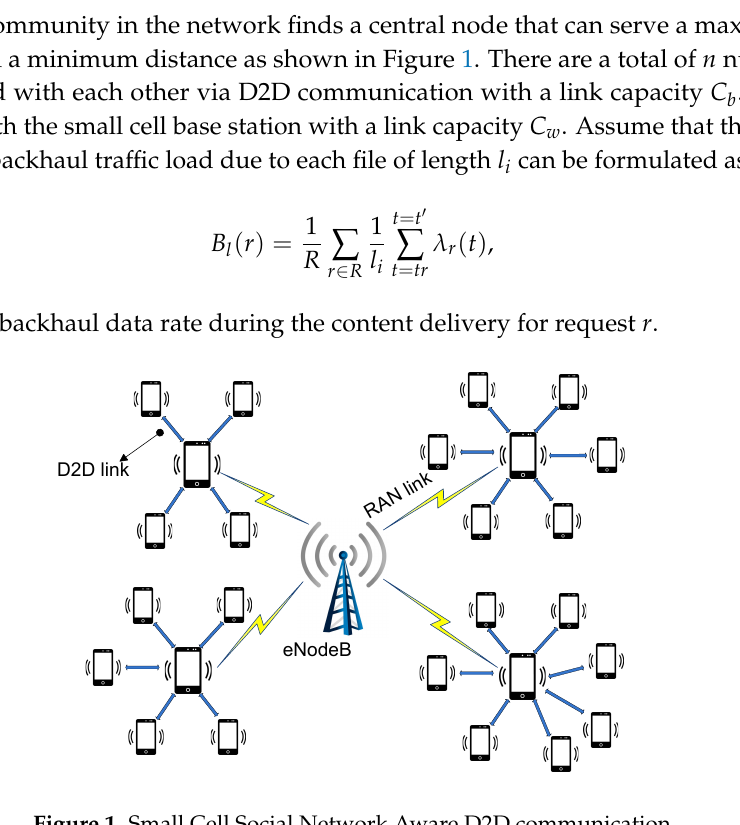
Figure 1. Small Cell Social Network Aware D2D